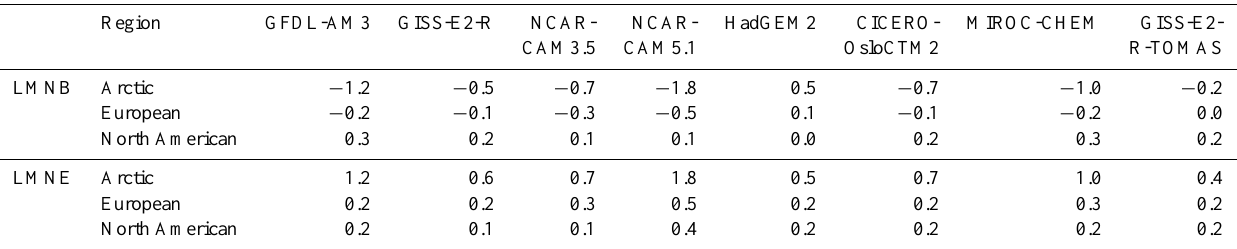
Fig. 8. Same as Fig. 7 but for CO mixing ratio. Note that the stations in Table 4 are excluded if the CO measurements are not available, and the measured CO is averaged with available data between 1996 and 2005. NCAR-CAM5.1 and HadGEM2 do not provide CO output. Note that Ny- ˚Alesund is shown as Ny-Alesund. Table 5. Log-mean normalized bias (LMNB) and log-mean normalized error (LMNE) of model present-day BC mass concentrations com- pared with the atmospheric surface observations listed in Table 4. Each site in Table 4 is categorized by the geography: Arctic, European, and North American